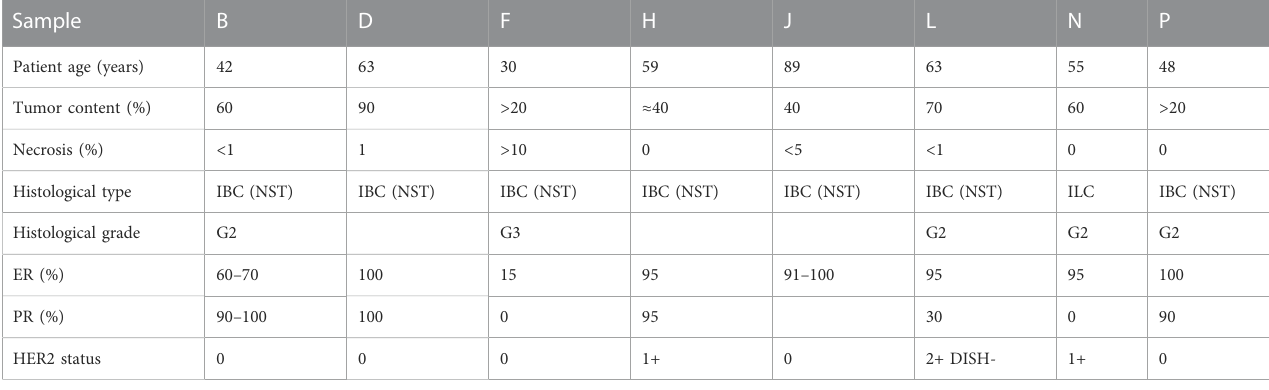
TABLE 2 Characteristics of ER+/HER2-breast carcinoma samples included in the second PIK3CA testing round.